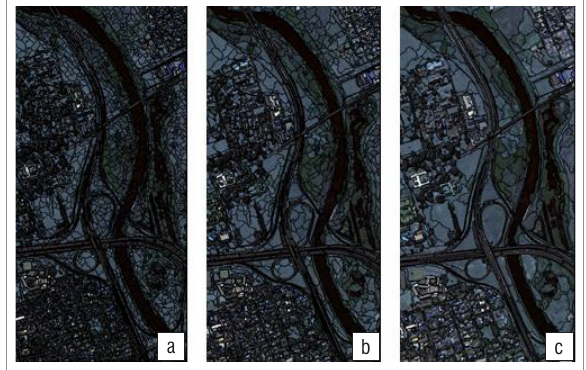
Figure 2: Image objects segmented with scale factors of (a) 30, (b) 50 and (c) 100. The derivations of the GLCM and GLDV textural features were performed using eCognition software. To achieve directional invariance, a summation of all four directions (0°, 45°, 90° and 135°) was